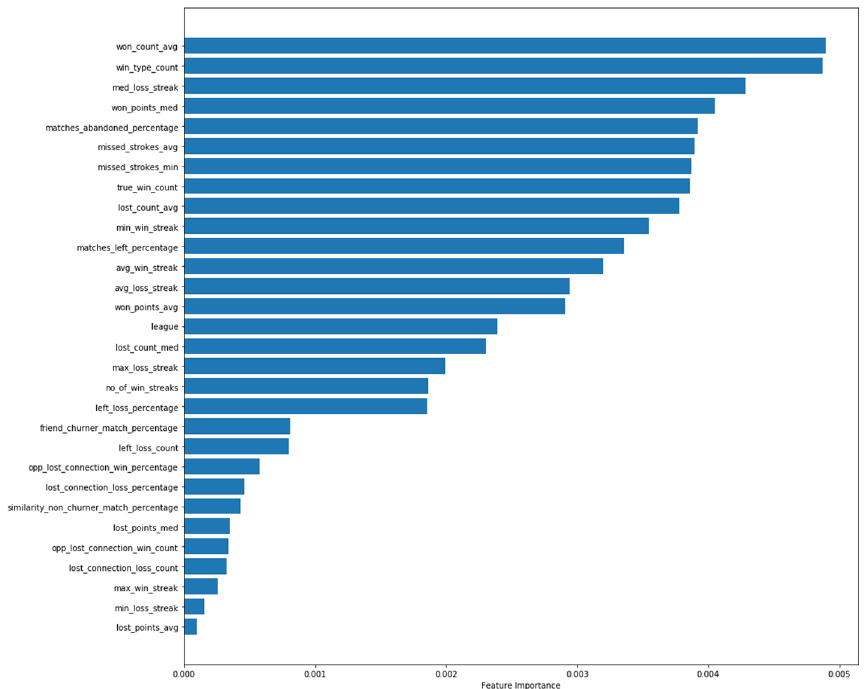
Fig. 5 Feature importance in the random forest model using the 3-day dataset and all the features